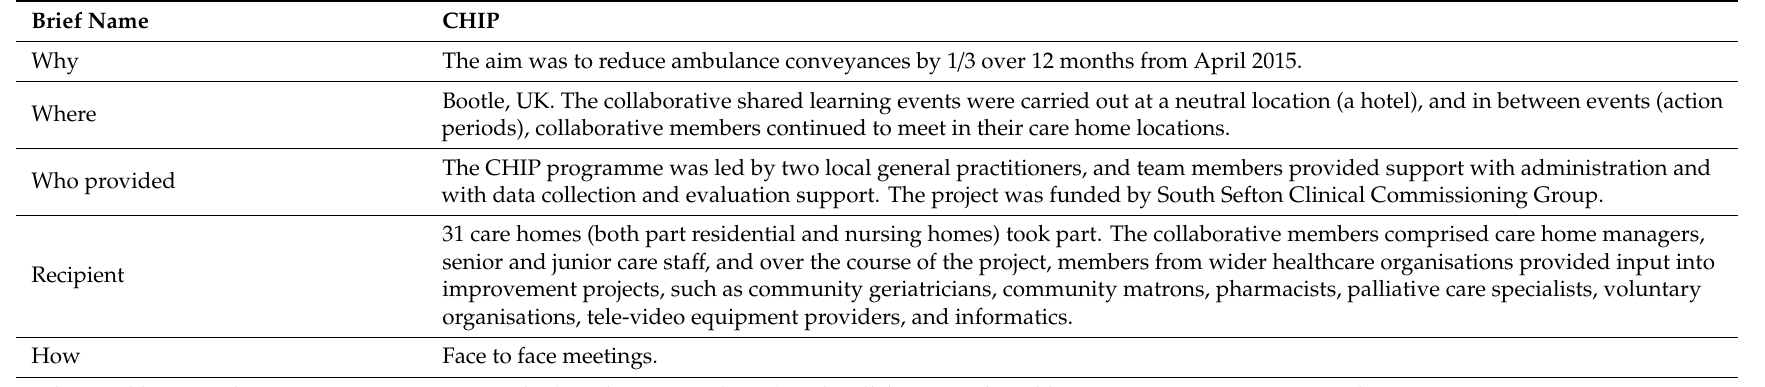
Table 6. Description of the South Sefton Care Home Innovation Program (CHIP) Quality Improvement